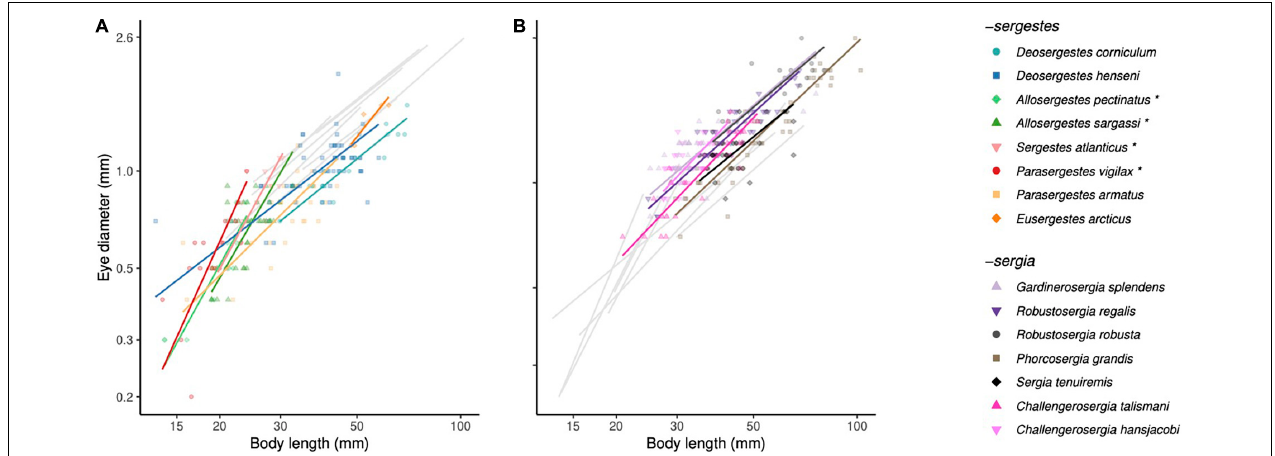
FIGURE 1 | Static allometry. Adult eye-body size allometry is shown for 15 species of sergestid shrimps. Neosergestes edwardsii was not included as a regression could not be fitted due to low sample size. Eye-body allometry for the (A) -sergestes and (B) -sergia groups have been separated, with the regression lines of the opposing groups shown in grey. Data for each species are indicated by combinations of symbol and coloration. Asterisks indicate species with significantly non-isometric eye-body allometry. Lines indicate standardized major axis (SMA) regressions of log 10 eye diameter vs. log 10 body